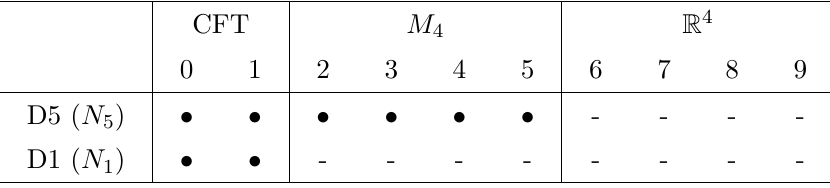
Table 2 . The D1/D5 brane